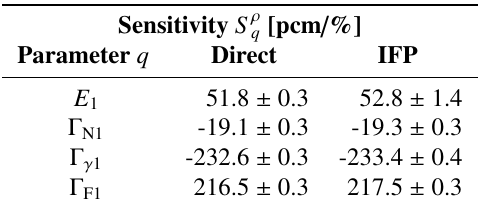
Table 2. Sensitivities to the first 239 Pu resonance parameters for the PST001 benchmark